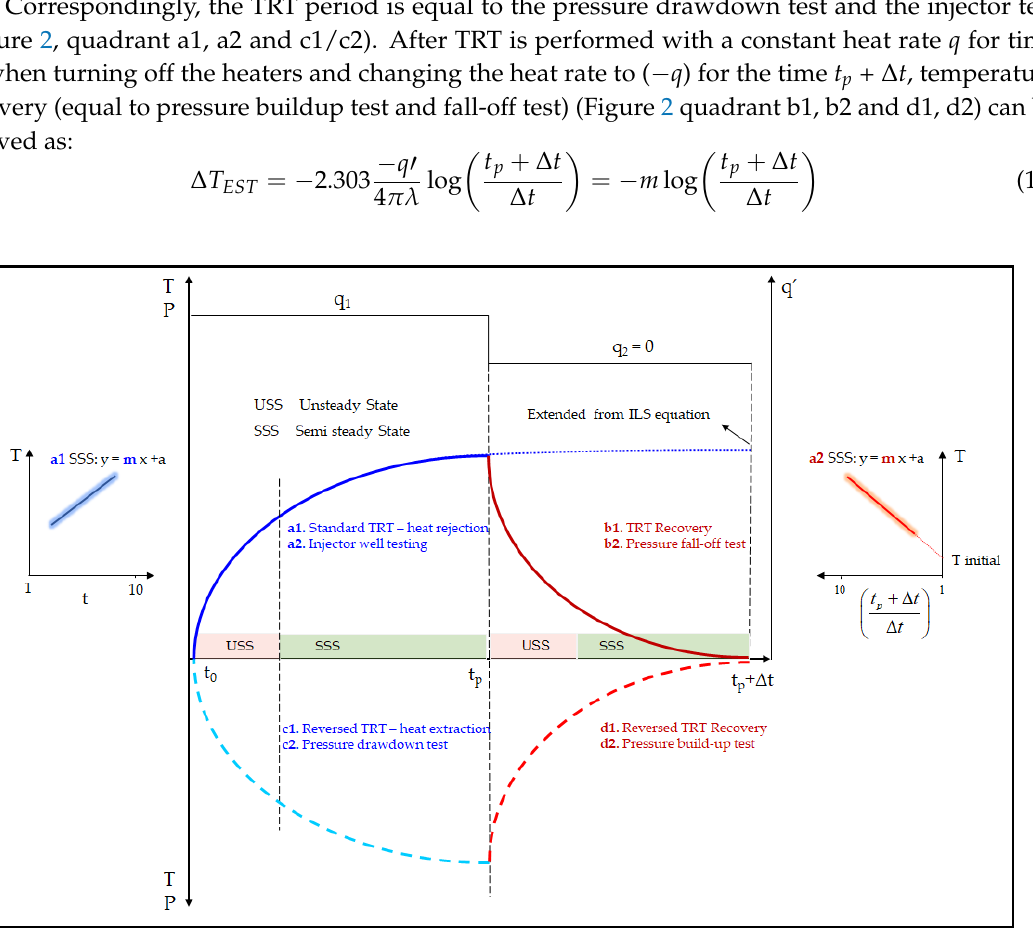
Figure 2. Display of corresponding behavior of pressure/temperature during different types of well tests/thermal response tests. tests/thermal response